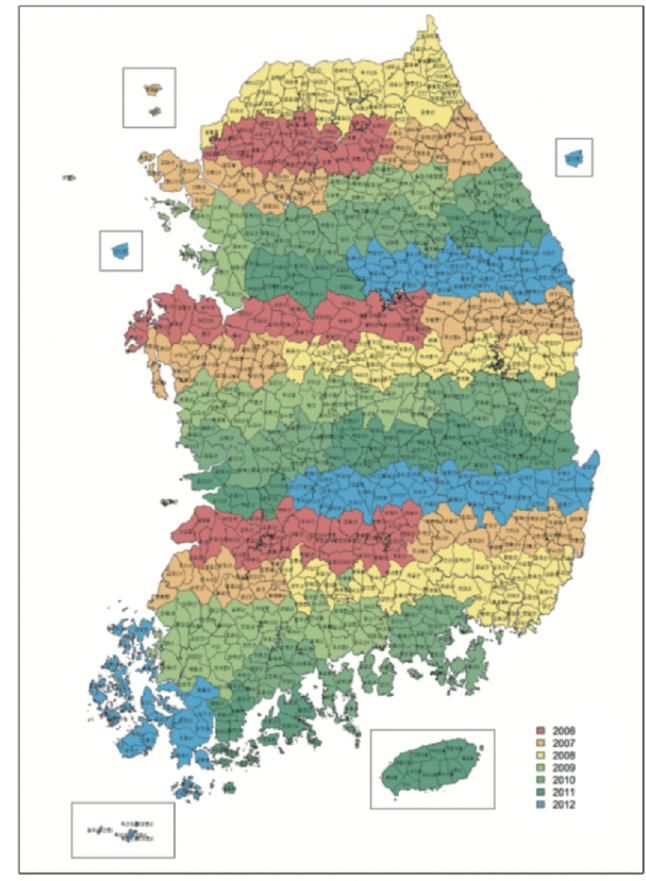
Figure 1. Areas in the 3rd National Ecological Survey. The surveyed elements include landform, vegetation, mammals, birds, amphibians, reptiles, insects, and fish (extracted from National Institute of Ecology’s guideline 2019). Table 1. Environmental variables